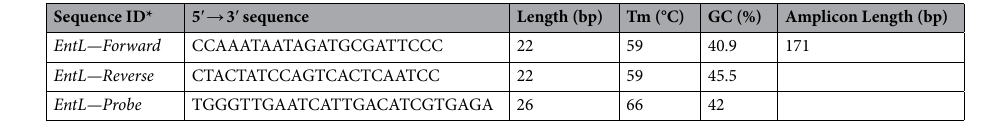
Table 2. Primer and probe set used in the E. lacertideformus -specific qPCR